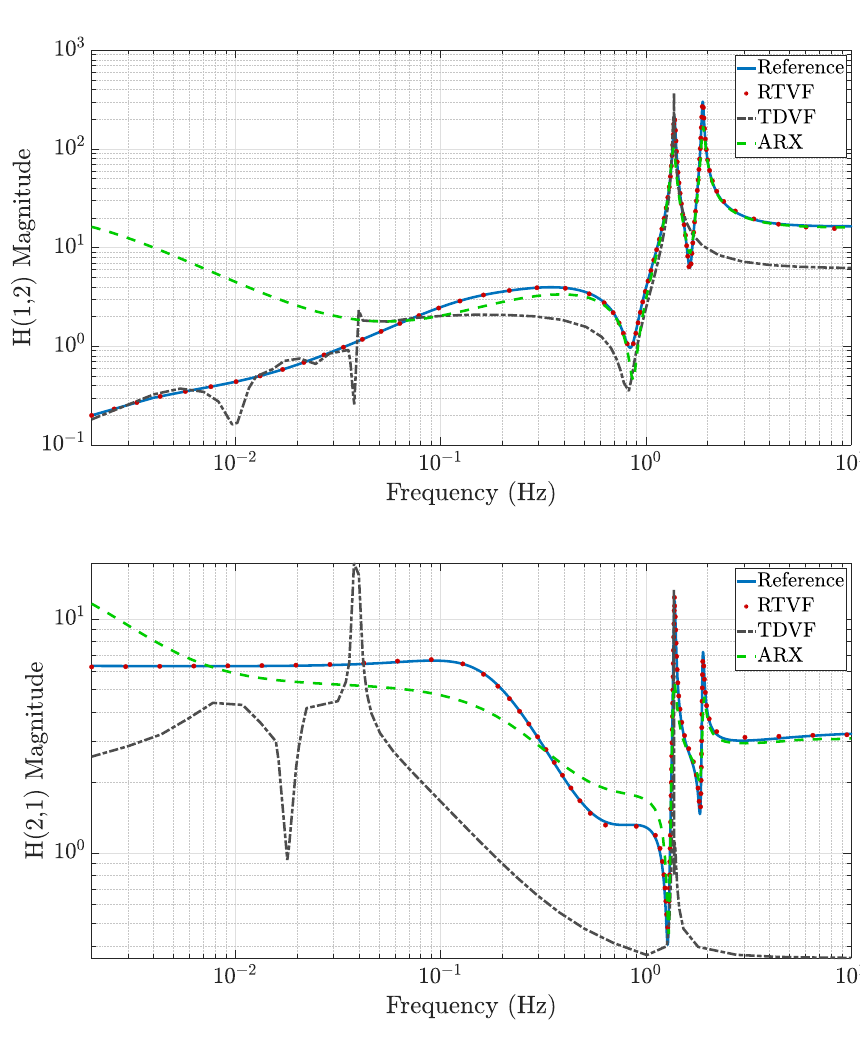
Figure 8. Selected transfer functions elements estimated by the RTVF, TDVF and ARX models, compared to the reference (exact)